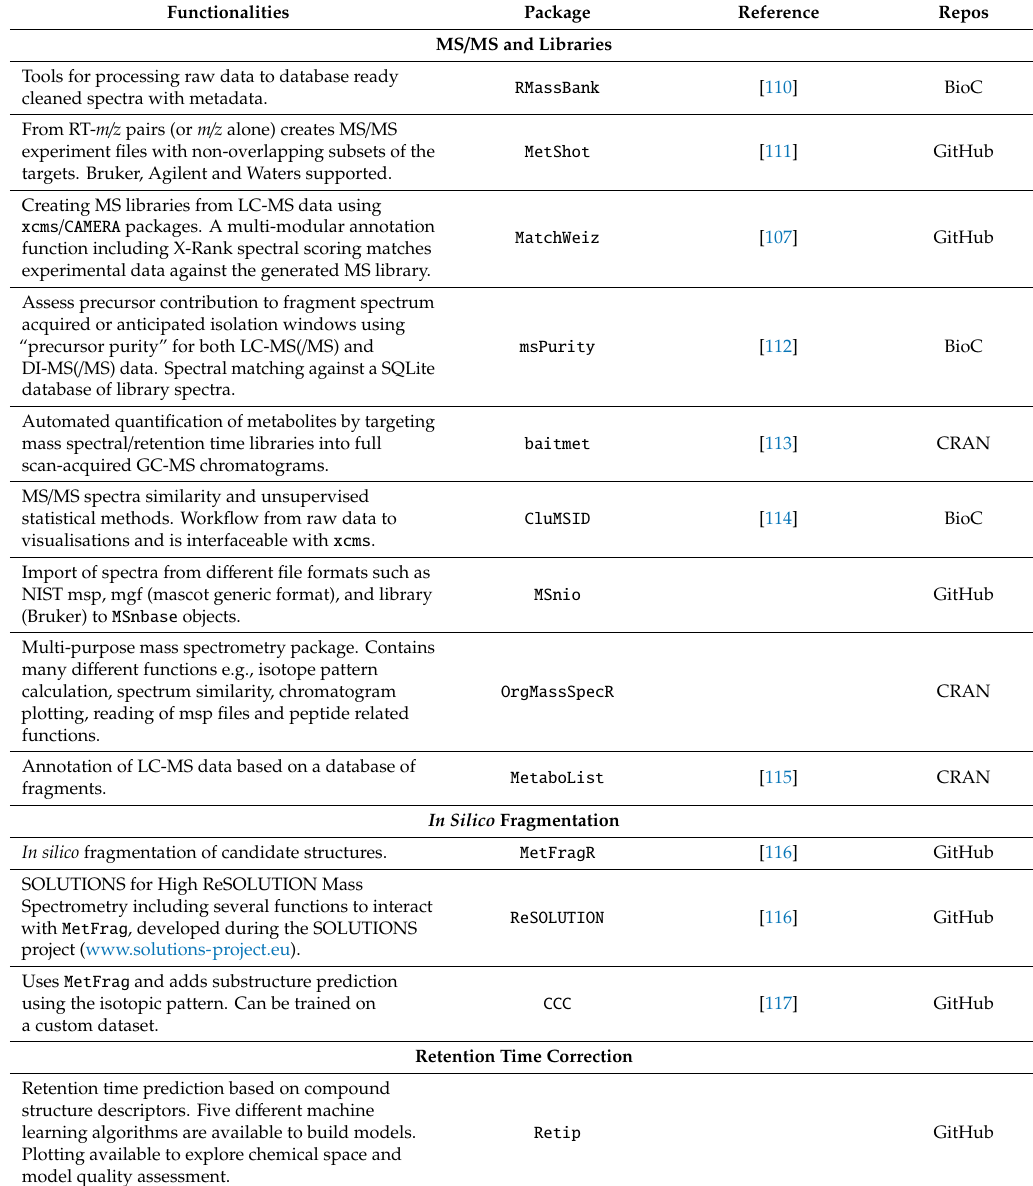
Table 3. R packages for MS / MS